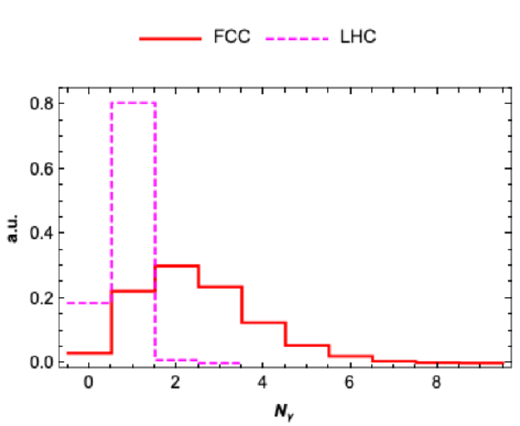
Figure 10 . Comparison of photon multiplicities N (cid:13) for the ggga signal events between the HL-LHC and the